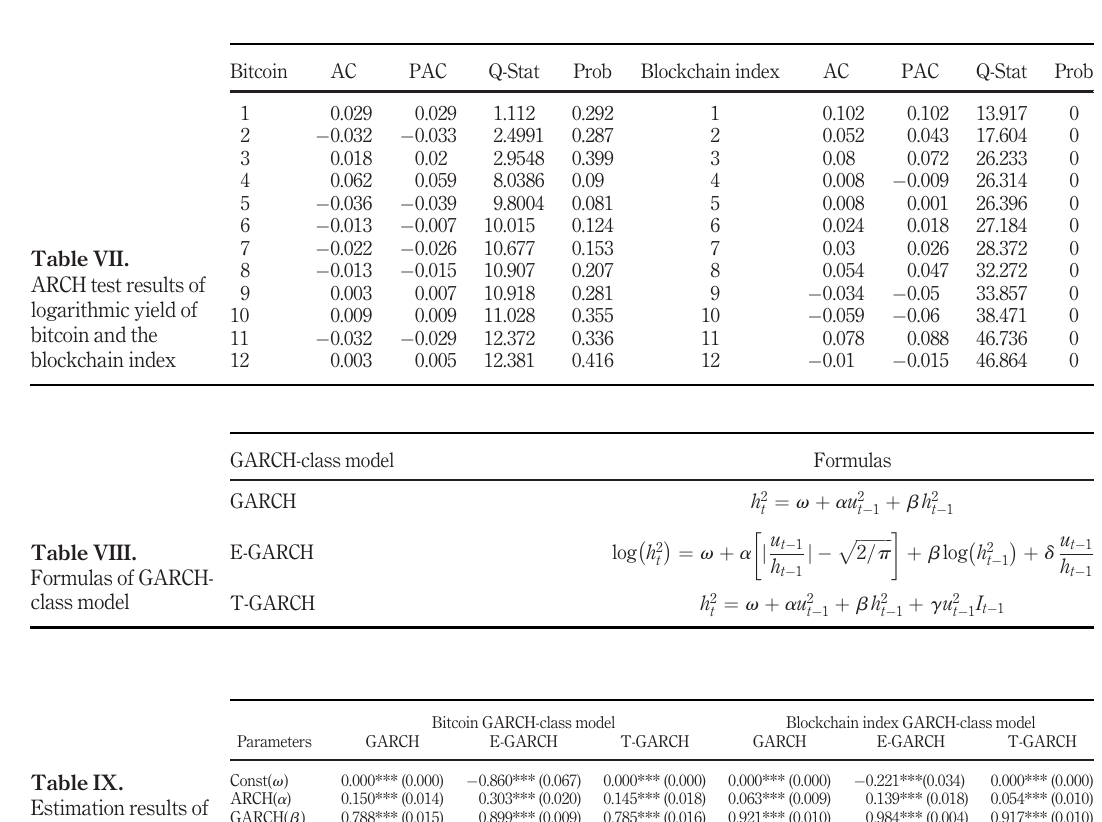
Table IX. Estimation results of logarithmic yield of bitcoin and the blockchain index by GARCH-class model